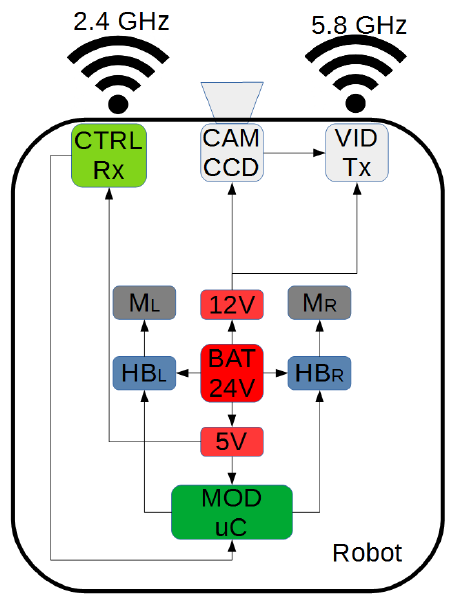
Figure 8. A concept of control system.